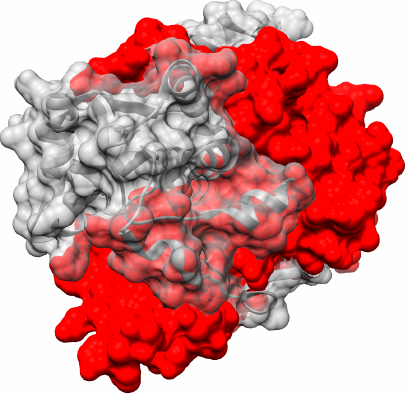
Figure 8. The extensive buried surface area of NfsB dimer (that of NfsA is larger still). The A chain is colored red with an opaque surface; the B chain is in grey with a partially transparent surface. One monomer wraps extensively around the other and buries much of its surface.